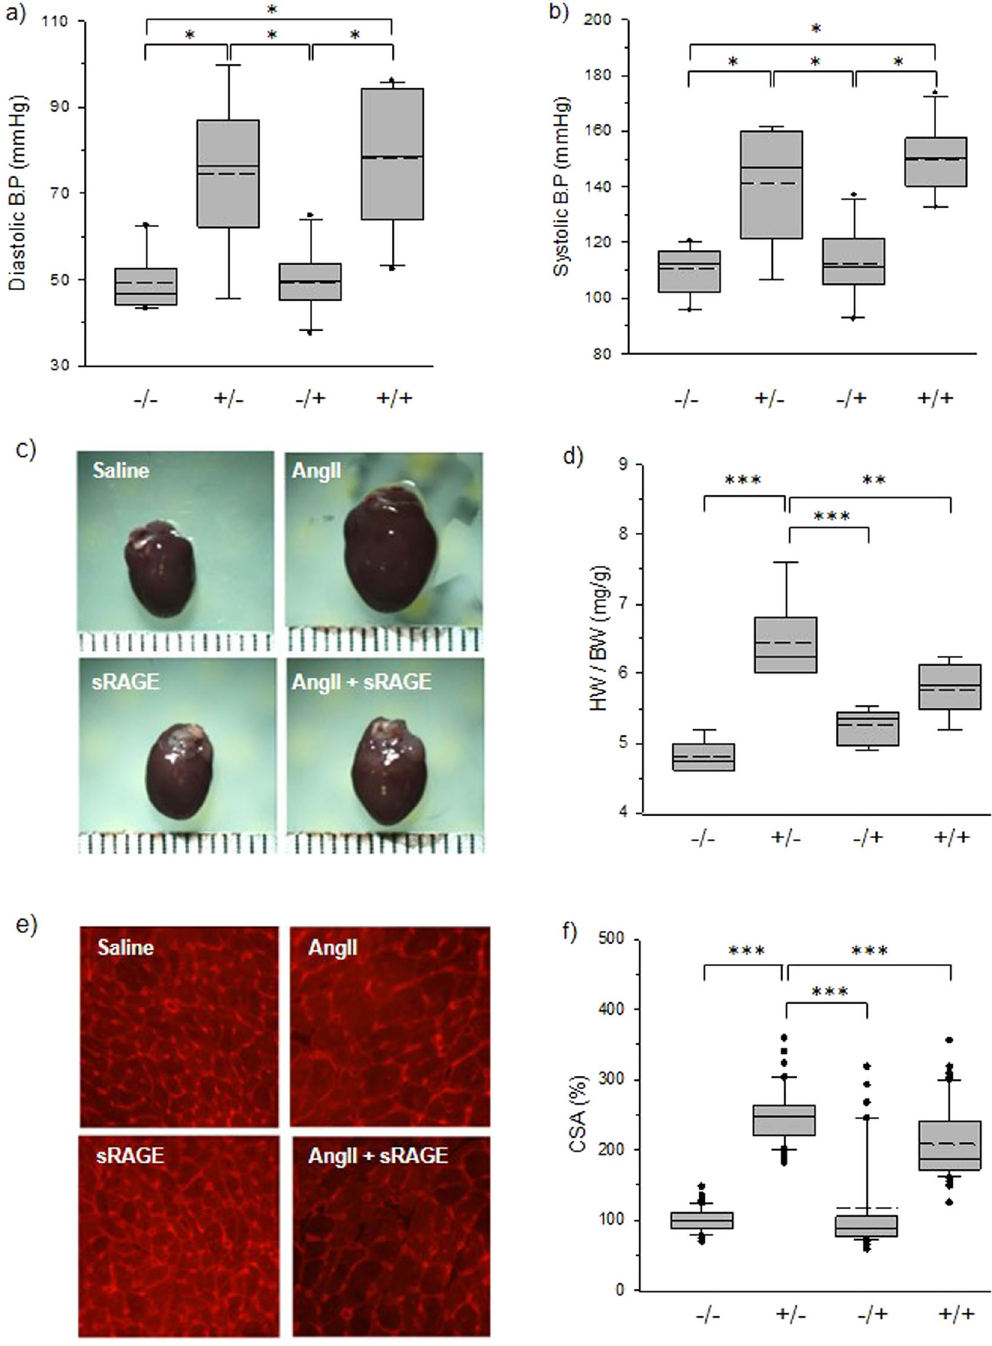
Figure 5. Blood pressure and histological analysis after CINE-MRI. ( a ) Diastolic blood pressure, ( b ) systolic blood pressure, ( c ) harvested heart images, ( d ) heart weight/body weight, ( e ) microscopic images of WGA- stained heart tissue, ( f ) CSA of myocardiocyte, * p < 0.01, ** p < 0.05, *** p <